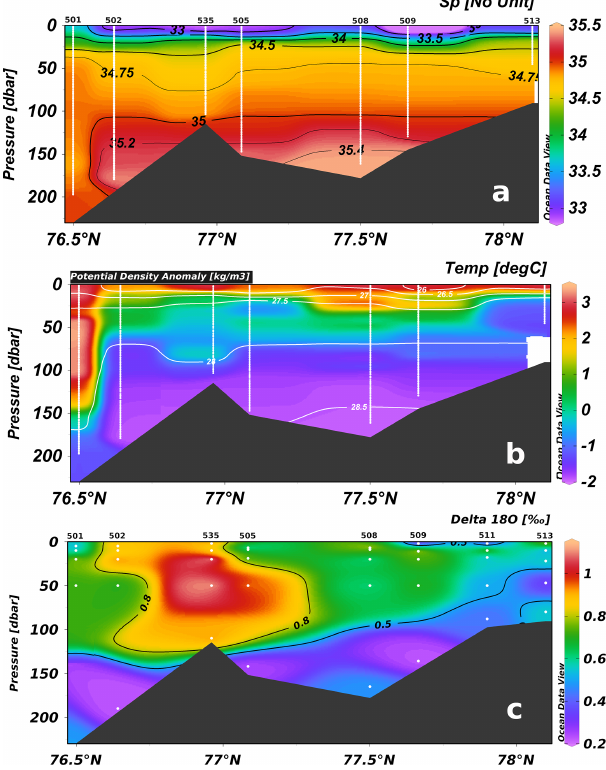
white isolines of potential density anomaly and (c) oxygen isotope ratio ( δ 18 O) from water samples along south–north transect (See Fig. 1), from the Storfjordrenna to the inner fjord. White lines in (a) and (b) indicate the location and depth of the CTD data, and in (c) white dots indicate the location of the water samples. Plots are made with Ocean Data View (Schlitzer, Reiner, Ocean Data View, https://odv.awi.de/, last access: 30 January